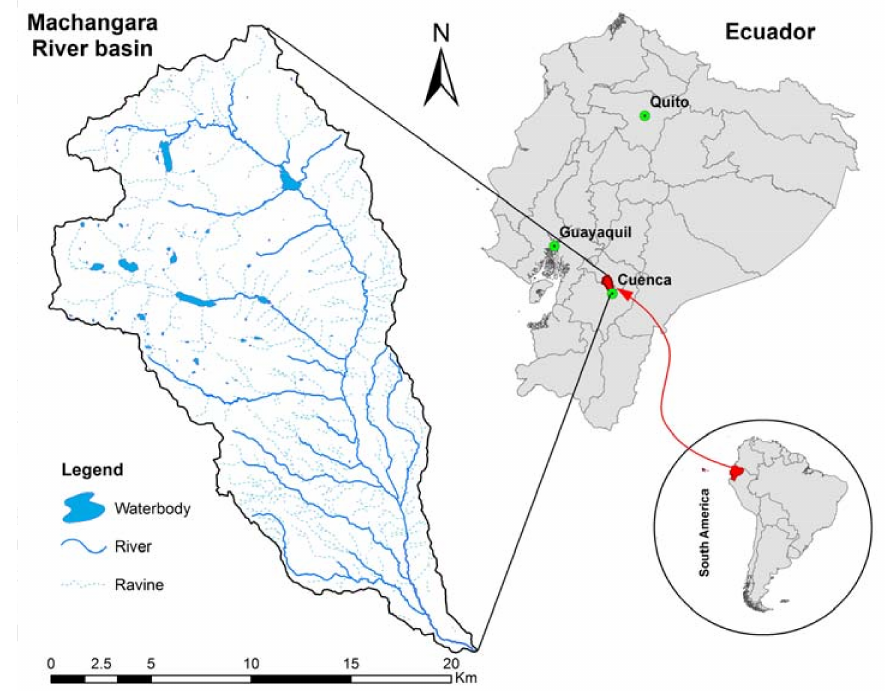
Figure 1. Location of the Machangara basin in